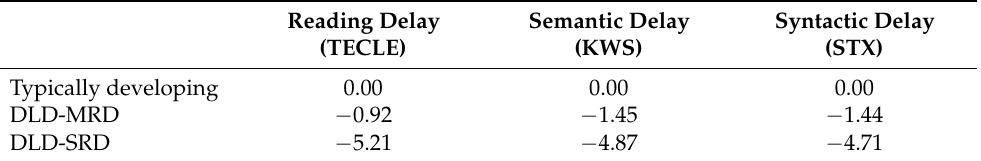
Table 2. Mean reading, semantic, and syntactic delays by group (typically developing, DLD-MRD, and DLD-SRD) in years. Reading Delay Semantic Delay Syntactic Delay (TECLE) (KWS) (STX) Typically developing 0.00 0.00